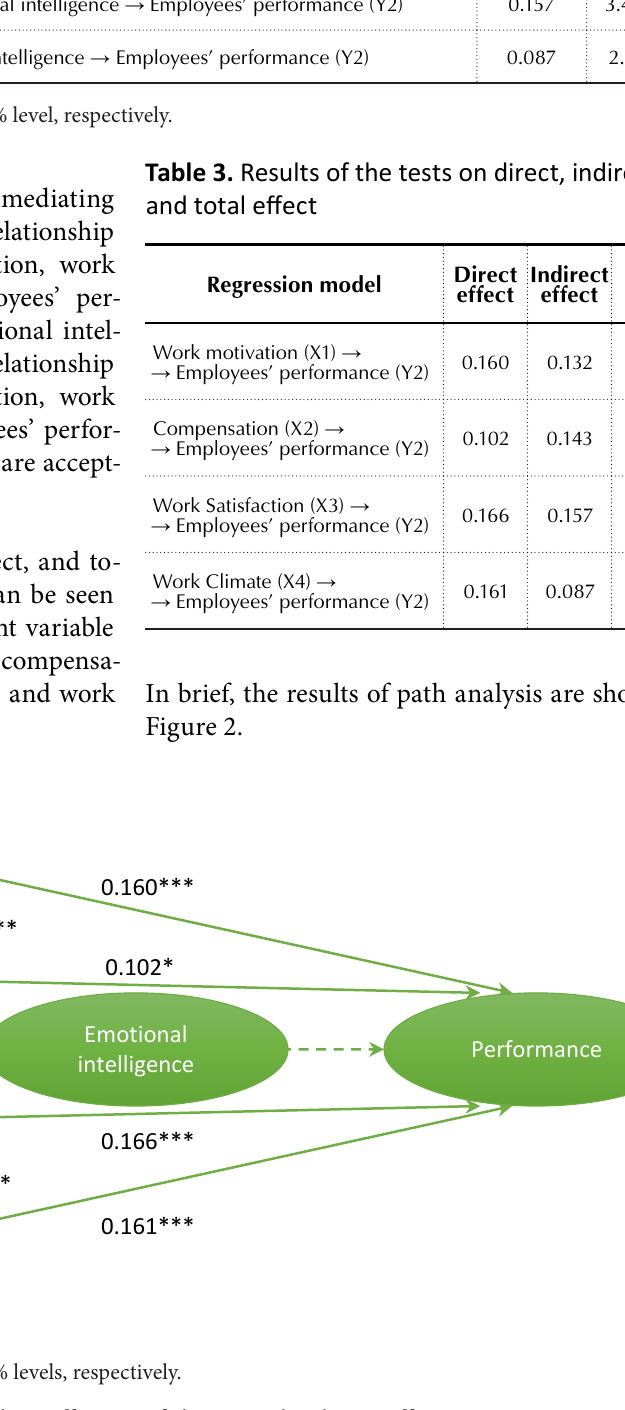
Figure 2. The path coefficient of direct and indirect